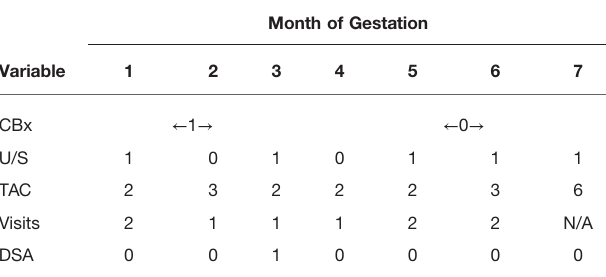
Month of Gestation